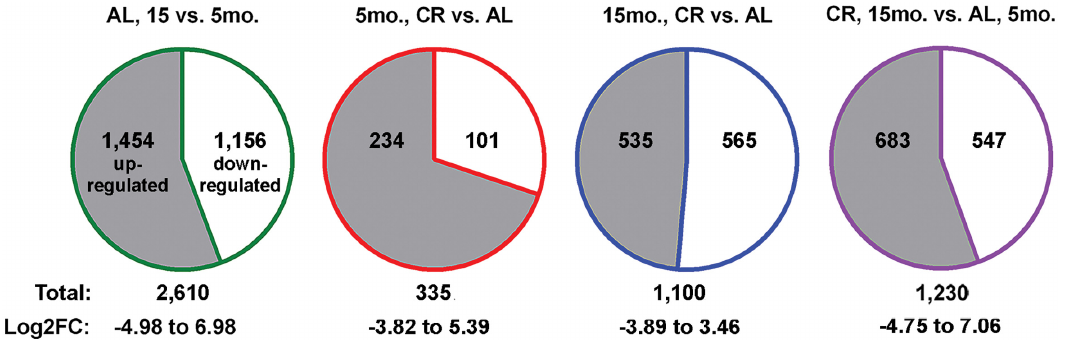
Fig 3. Differential gene expression via mRNA sequence analysis pairwise comparisons. The total number of differentially expressed transcripts identified by total mRNA sequencing within each pairwise comparison are indicated, along with the log 2 fold change (Log2FC) range and the number of upregulated (gray) and downregulated (white) targets (p < 0.01, q <